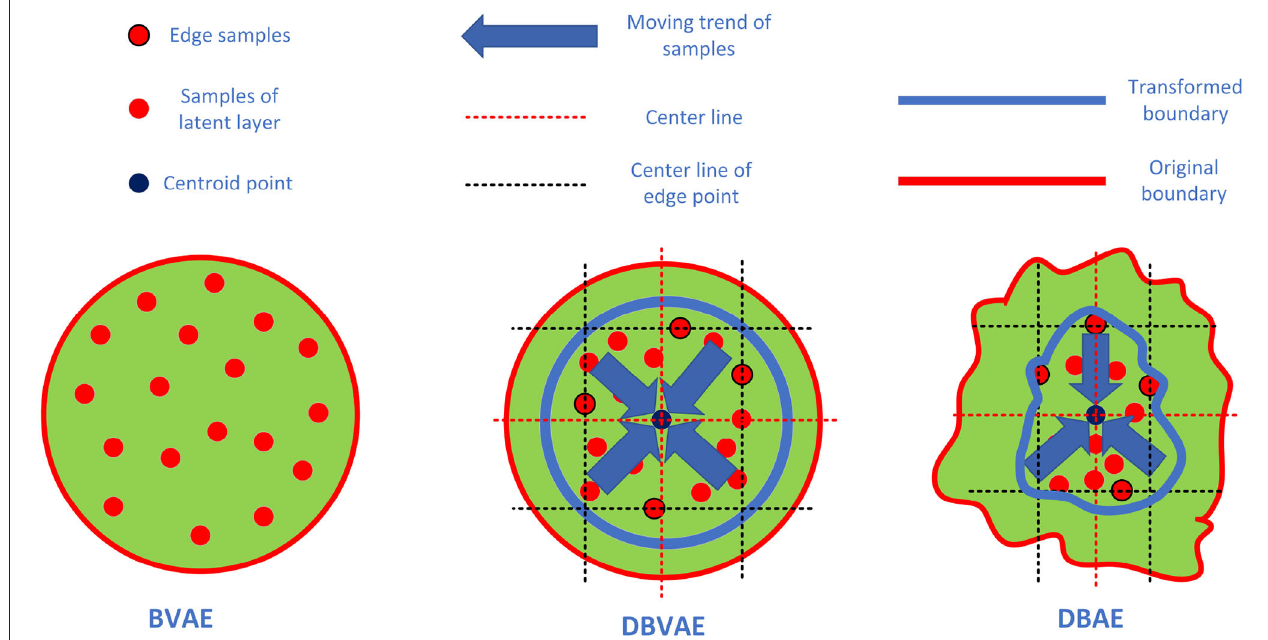
FIGURE 1 | In the BVAE method, the latent space only ensures that the sample points roughly obey the standard normal distribution, but there is no specific requirement for the density of the sample points. In the DBVAE method, the latent space not only retains the characteristic that the sample points obey the standard normal, but also makes the samples more aggregated by increasing the sample density. The whole process is shown in the figure, taking two-dimensional plane as an example. Firstly, the edge sample is determined, and the center line of the edge point is made according to the center of the edge sample on each dimension. Secondly, the average of the center lines of the edge points is calculated to get the center line, and the intersection of the center lines of different dimensions is defined as the centroid point. Finally, all the sample points shrink to the centroid. In the method of DBAE, the distribution assumption of sample points is canceled and only the sample density is required. The samples shown in the figure are normal sample points during the training process.